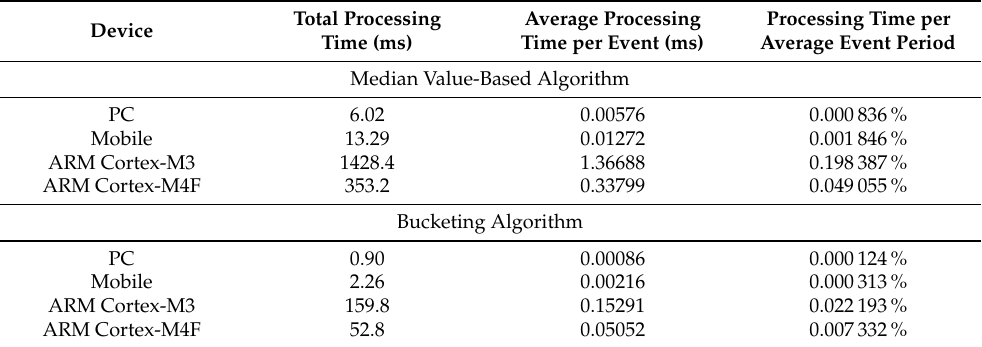
Table 6. Event processing time for PC, Mobile, and two ARM processors for 1045 events generated during a 12 min